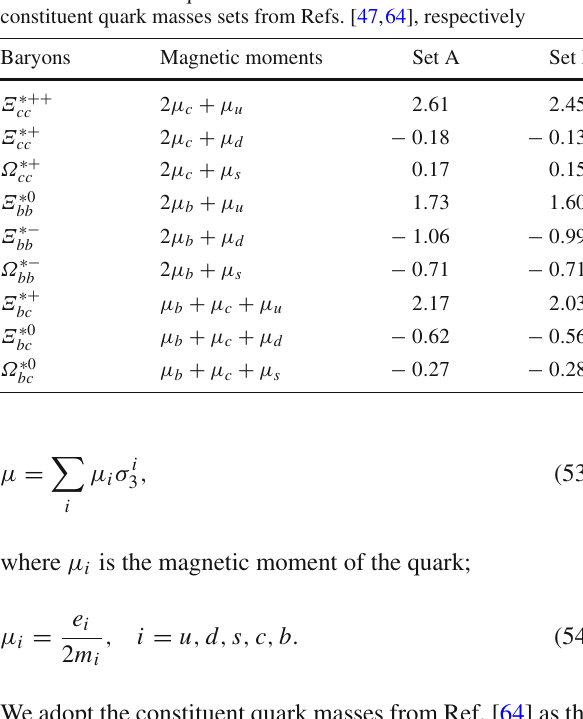
Table2 Thenumericalresultsofspin- 3 moments from naive quark model estimation. Set A and set B are